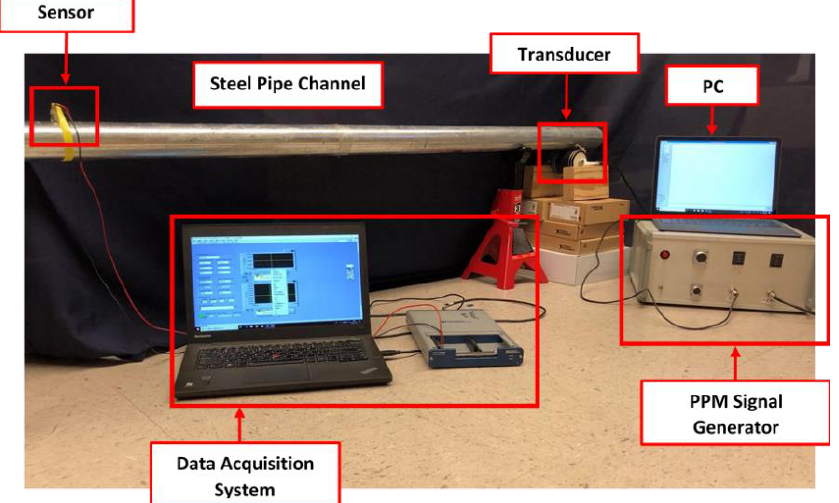
Figure 13. Experimental setup.